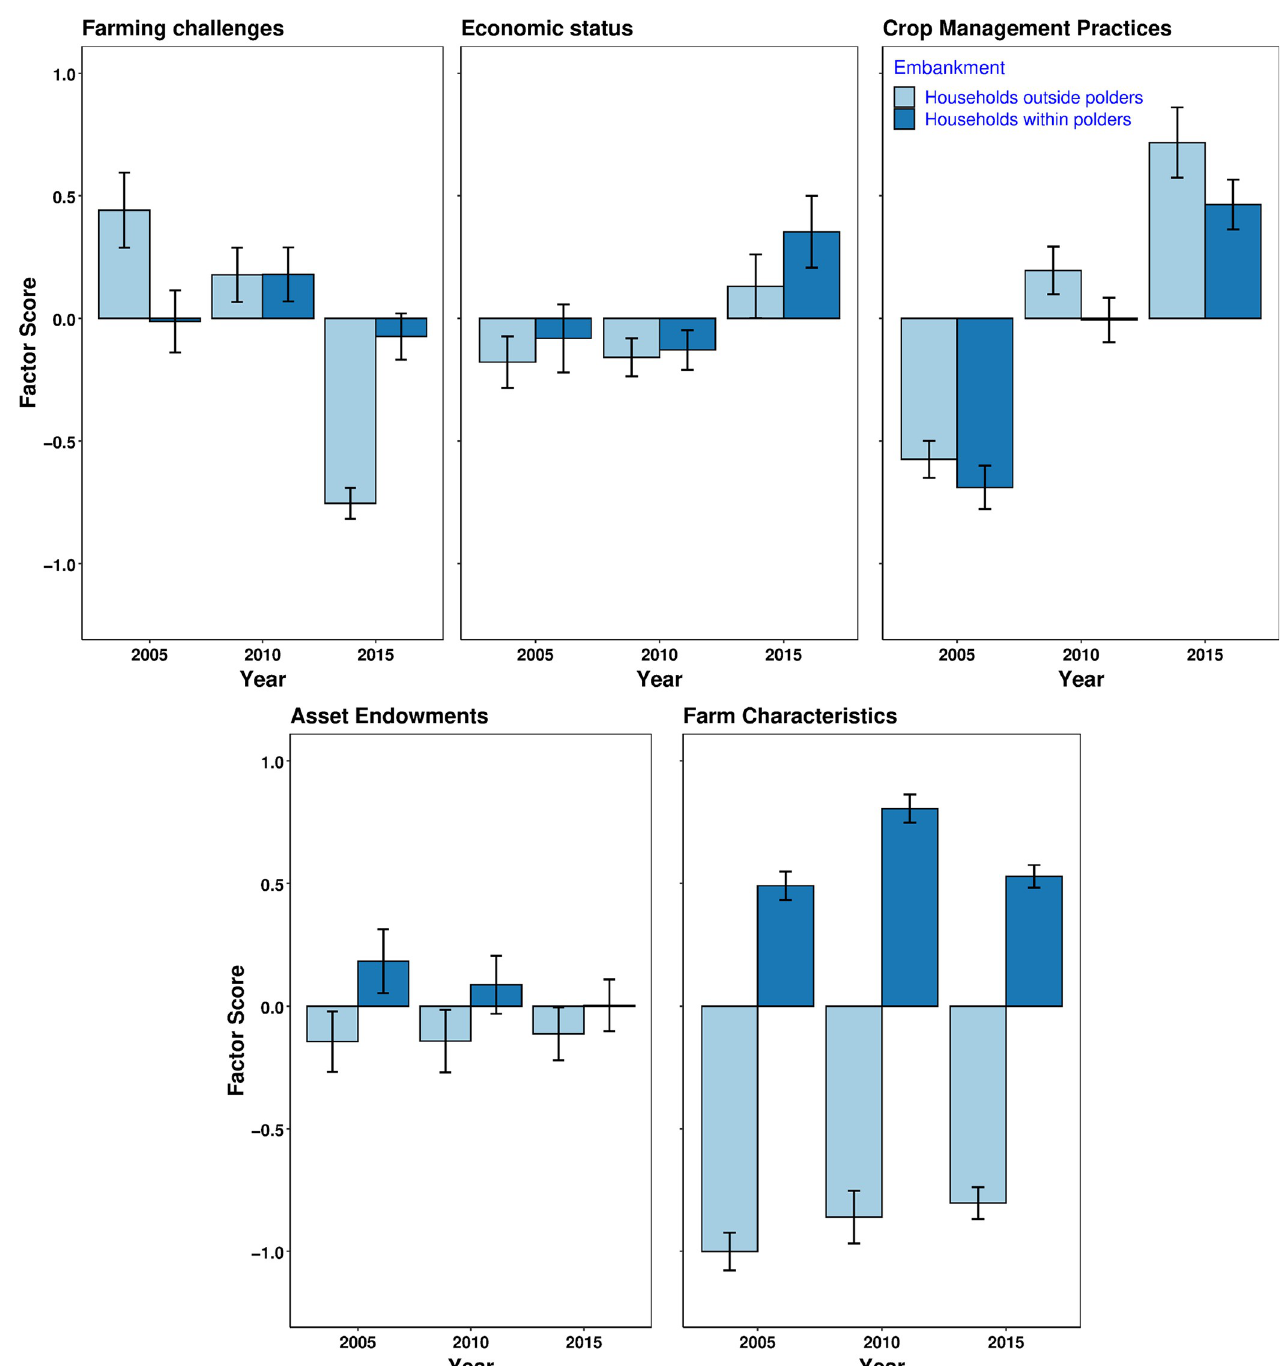
Fig 3. Change in factors over time during the study period (error bars indicate 95% confidence intervals). Factors are independent and represent key differences in smallholder farming systems for households within and outside polders in the study area. closer proximity to the coastline (bottom panel in Fig 4). In addition, decreasing distance to canals that could be used for surface water irrigation and changes in the involvement of the household head in farming were influential in households outside polders (Fig 4).